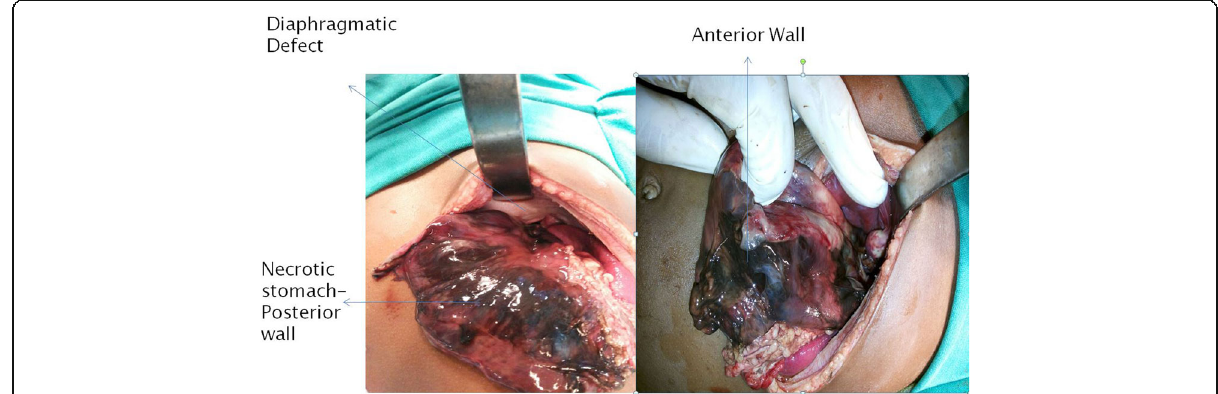
Fig. 3 Intra-operative findings